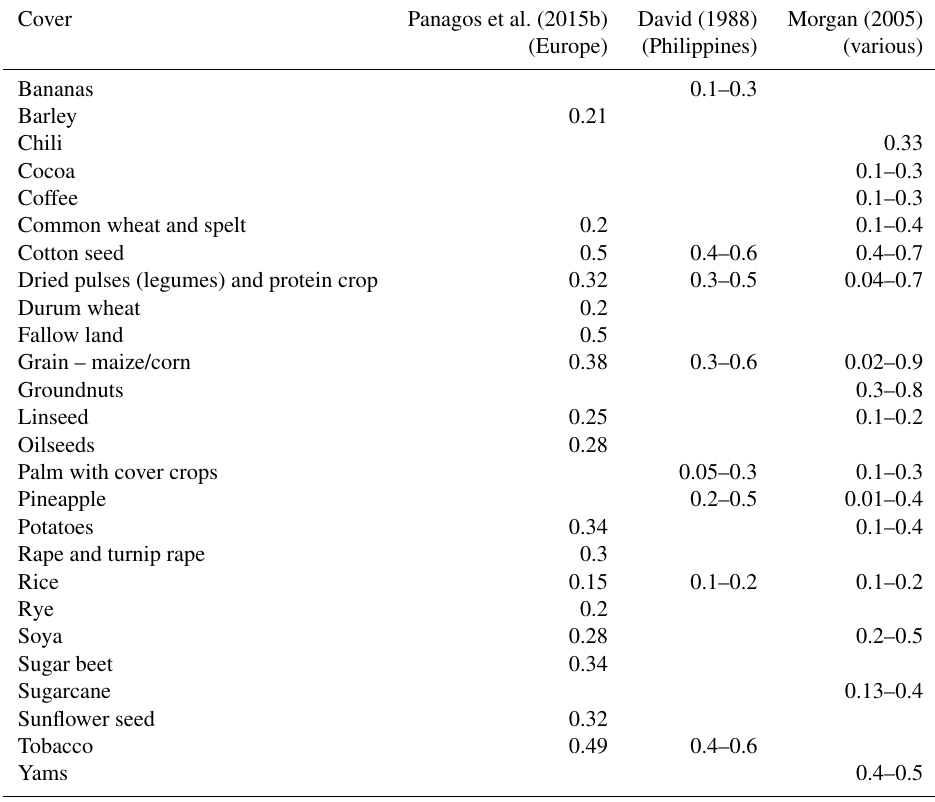
Table 9. C factors for specific types of land cover compiled from various sources.